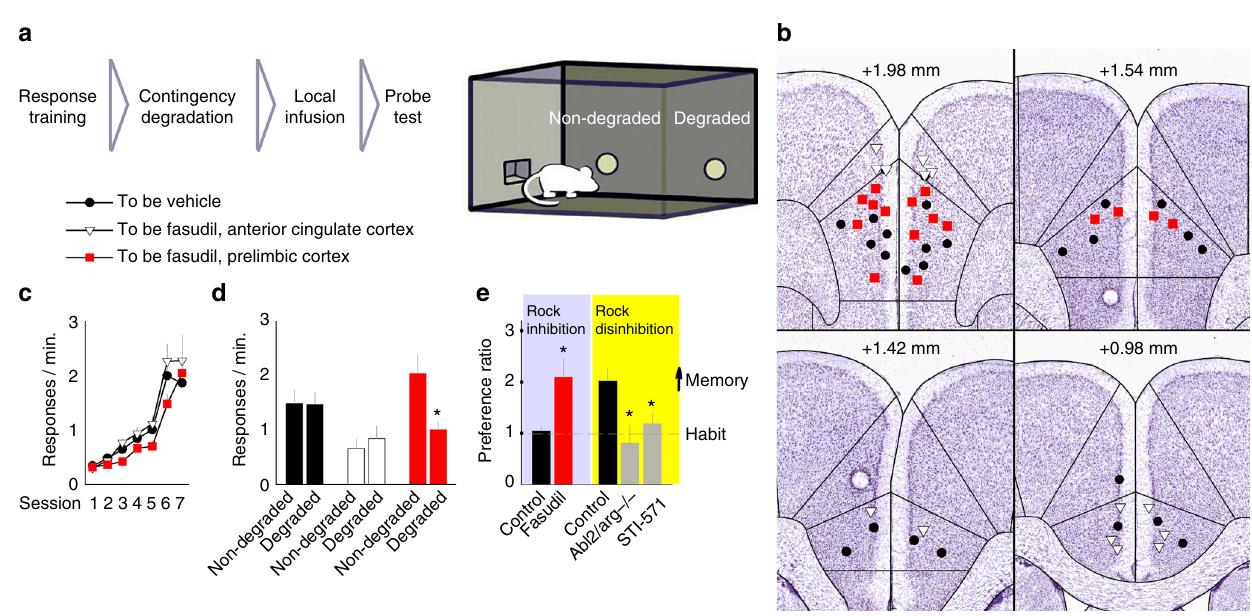
Fig. 3 Bidirectional coordination of action – outcome memory. a Experimental timeline: mice were trained to respond for food reinforcement. Immediately after instrumental contingency degradation, vehicle or fasudil was infused into either the prelimbic or anterior cingulate cortex. b Infusion sites, with coordinates relative to Bregma, are indicated on images adapted from the Allen Brain Atlas. c All mice acquired the responses, with no differences between groups. d Subsequently, vehicle-infused mice failed to differentiate between the responses that were more, vs. less, likely to be reinforced (non-degraded vs. degraded), deferring to habit-based behavior. By contrast, prelimbic cortical infusions of fasudil produced a preference for the response most likely to be reinforced, whereas fasudil in the anterior cingulate cortex had no effects ( n = 12 combined control, 8 prelimbic, 7 anterior cingulate). e The same data are represented as preference ratios (non-degraded/degraded), with values > 1 indicating goal-directed responding. Vehicle-infused mice responded at chance levels (habit), whereas prelimbic fasudil-infused mice utilized a goal-directed response strategy. Right: by contrast, in mice trained to be sensitive to action – outcome relationships, knockout of the endogenous ROCK inhibitor Abl2/arg or local infusion of an Arg inhibitor STI-571 ablated response preference, indicating impaired action – outcome decision making ( n = 9 combined control, 6 arg − / − , 10 STI-571). Raw data are reported in Supplementary Fig. 3. Bars and symbols = means + s.e.m., * p < 0.05. For each experiment, > 2 cohorts of mice were tested. We thank A. Allen for generating the illustration used in this fi